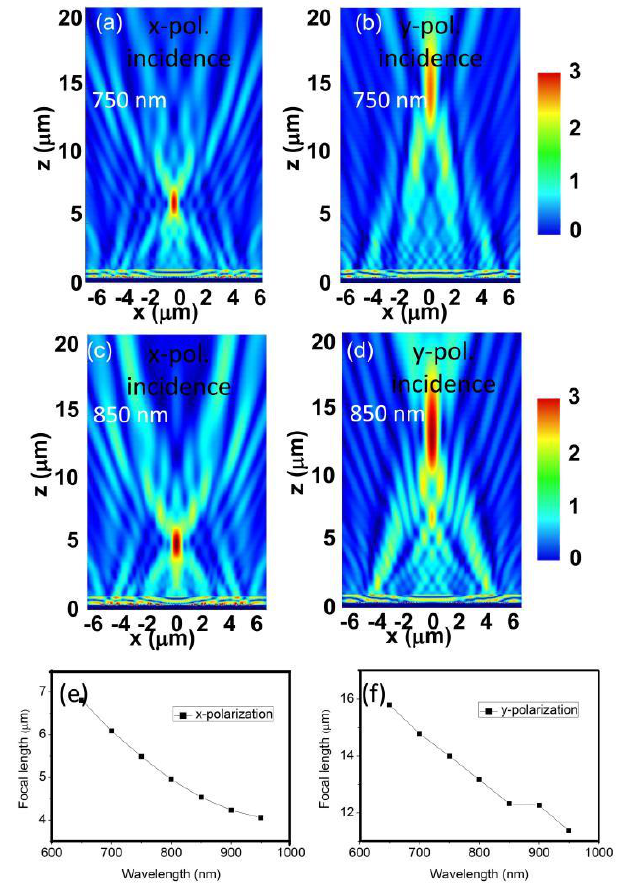
Figure 5. The electric field intensities for ( a ) x- and ( b ) y-polarization incidences with the incident wavelength of 750 nm. The electric field intensities for ( c ) x- and ( d ) y-polarization incidences with the incident wavelength of 850 nm. ( e ), ( f ) The focal lengths with different incident wavelengths for x- and y-polarization incidences, respectively.